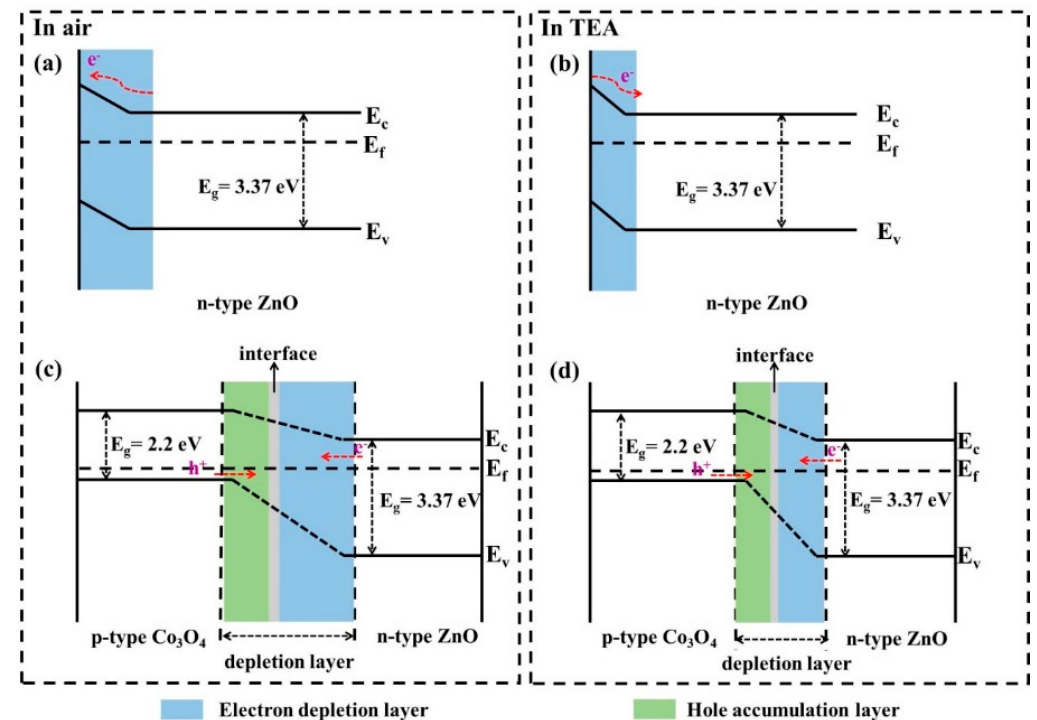
Figure 7. The energy band diagrams of ( a , b ) ZnO and ( c , d ) Co 3 O 4 -ZnO during exposure to air and TEA, respectively.